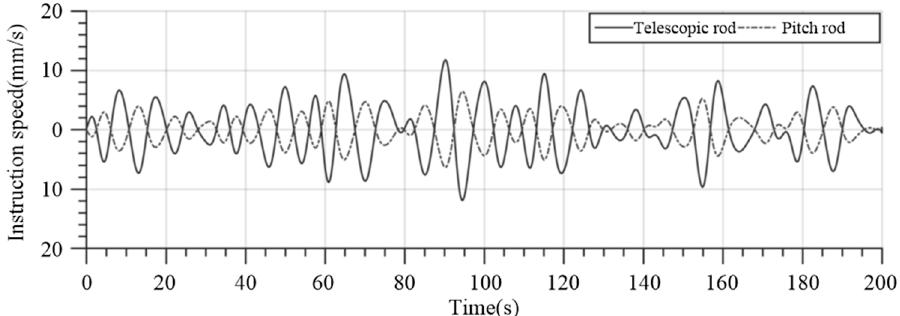
Figure 18. Command speed of gangway telescopic rod and pitch rod when the ship is equipped with passive anti-rolling tank.